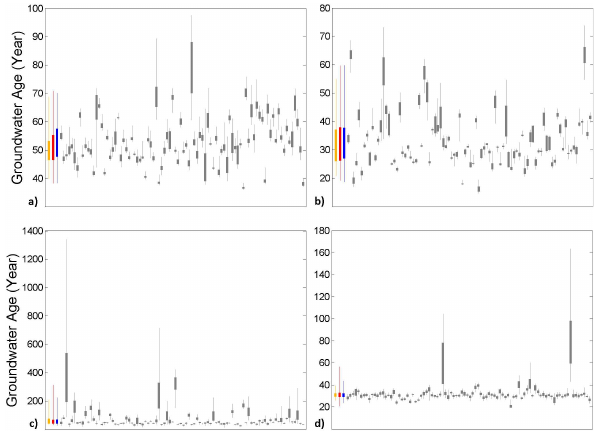
Fig. 12. Boxplot of simulated travel times for four wells: (a) W1, (b) W2, (c) W3, (d) W4. The yellow color plots represent 90 sim- ulations from GeoModel-I, the red color plots represent 90 simu- lations from GeoModel-II, the blue color plots represent GeoPar- Model, and the gray color plots represent simulations of individual ParModels, each consisting of 216 simulations. The edges of the boxes are the 25th and 75th percentiles, and the whiskers extend to the 2.5th and 97.5th percentiles (values are listed in Table